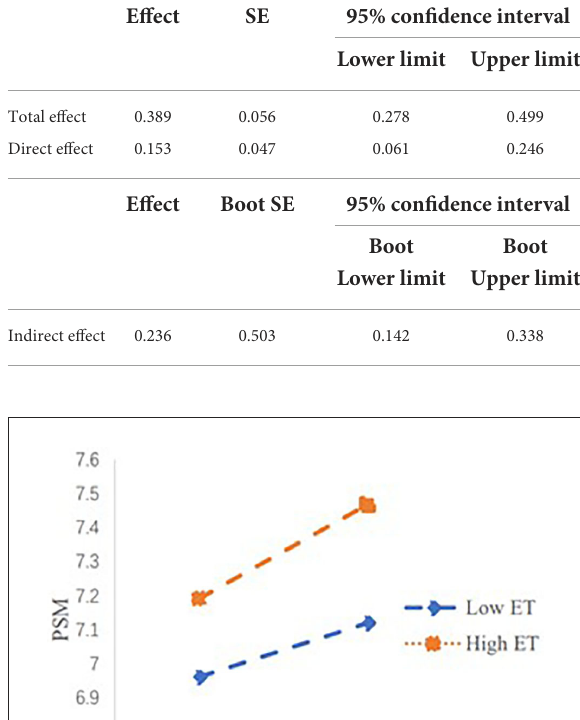
TABLE 4 Mediation effect of PSM based on bootstrap.